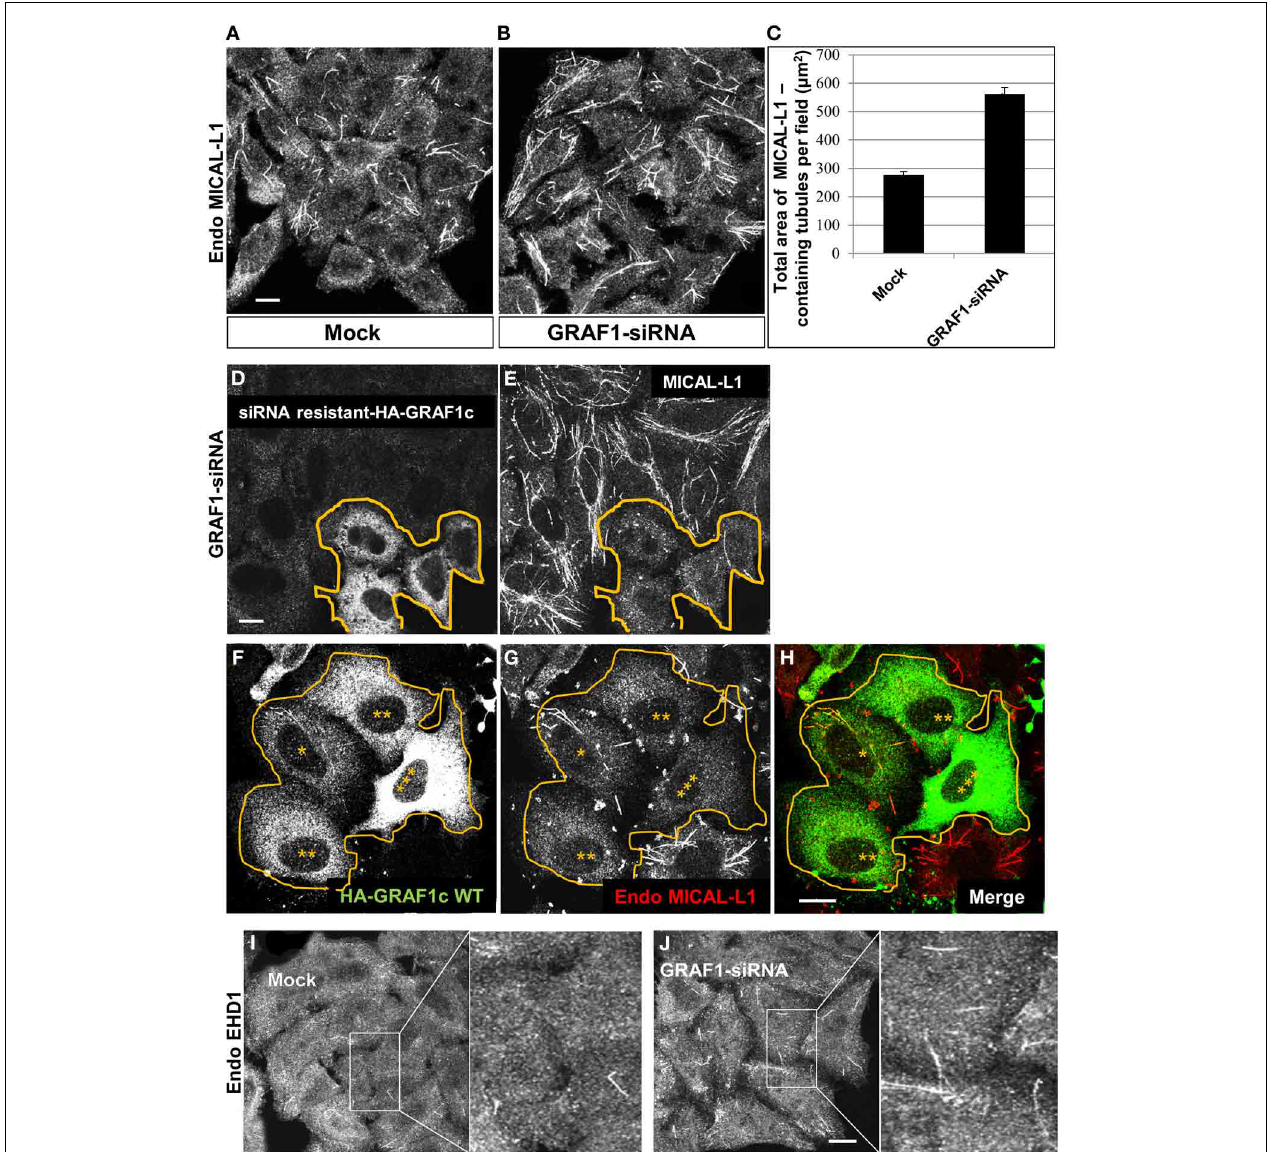
FIGURE 3 | GRAF1vesiculatesMICAL-L1-andEHD1-decoratedmembrane tubules. (A) HeLa cells grown on coverslips were either mock-treated or (B) treated with GRAF1-siRNA for 72h. After fixation, cells were stained with mouse anti-MICAL-L1 antibody for 1h, followed by Alex 568-goat anti-mouse secondaryantibody. (C) ThetotalareaofMICAL-L1-containing tubulesperfield in both mock-treated and GRAF1-siRNA-treated cells was quantified by using Image J from three independent experiments ( represented in A,B) . Error bars represent standard error; p < 0 . 001. (D,E) siRNA resistant-HA-GRAF1c was re-introduced into GRAF1-depleted cells for 24h followed by fixation. Fixed